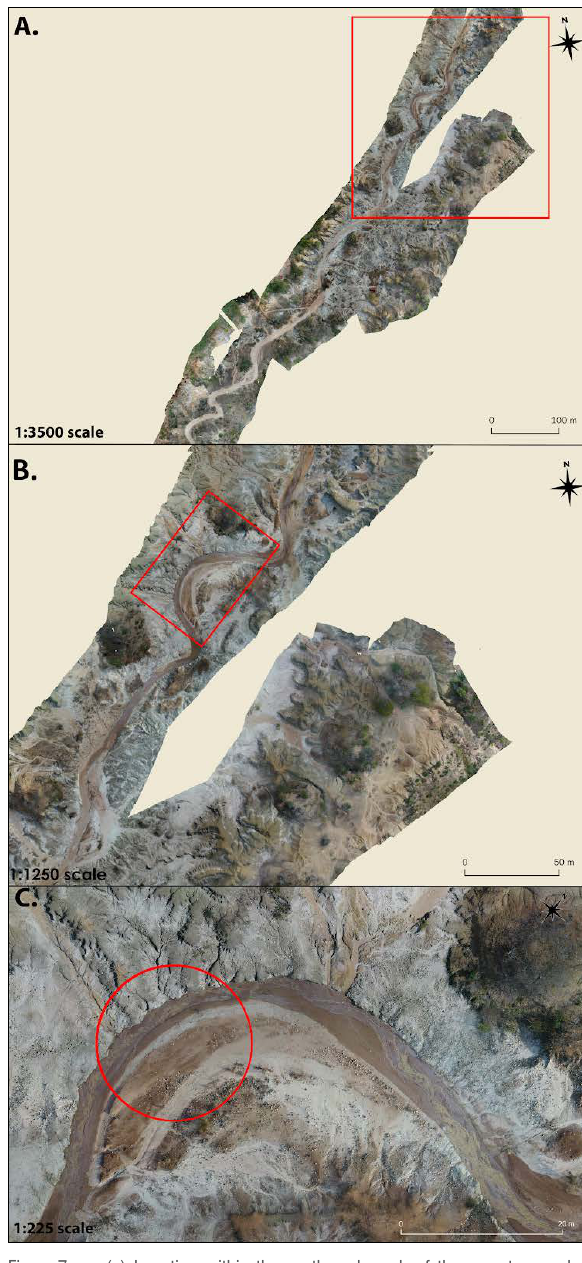
(a) Location within the northern branch of the recent meander outlined in red. (b) Inset of location of recent meander. (c) Detail of recent meander with approximate location of H10 4 trench circled in